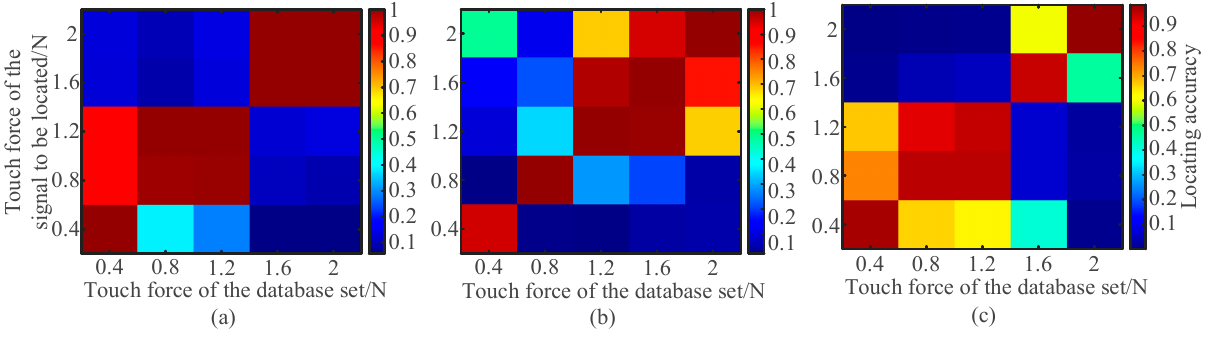
Figure 7. Cross-validation results indicating the tolerance zone of LWT to the variation in touch force. ( a – c ) Cross-validation results obtained with the databases with labelled touch area of A t = 64 mm 2 , A t = 16 mm 2 , and A t = 4 mm 2 , respectively.